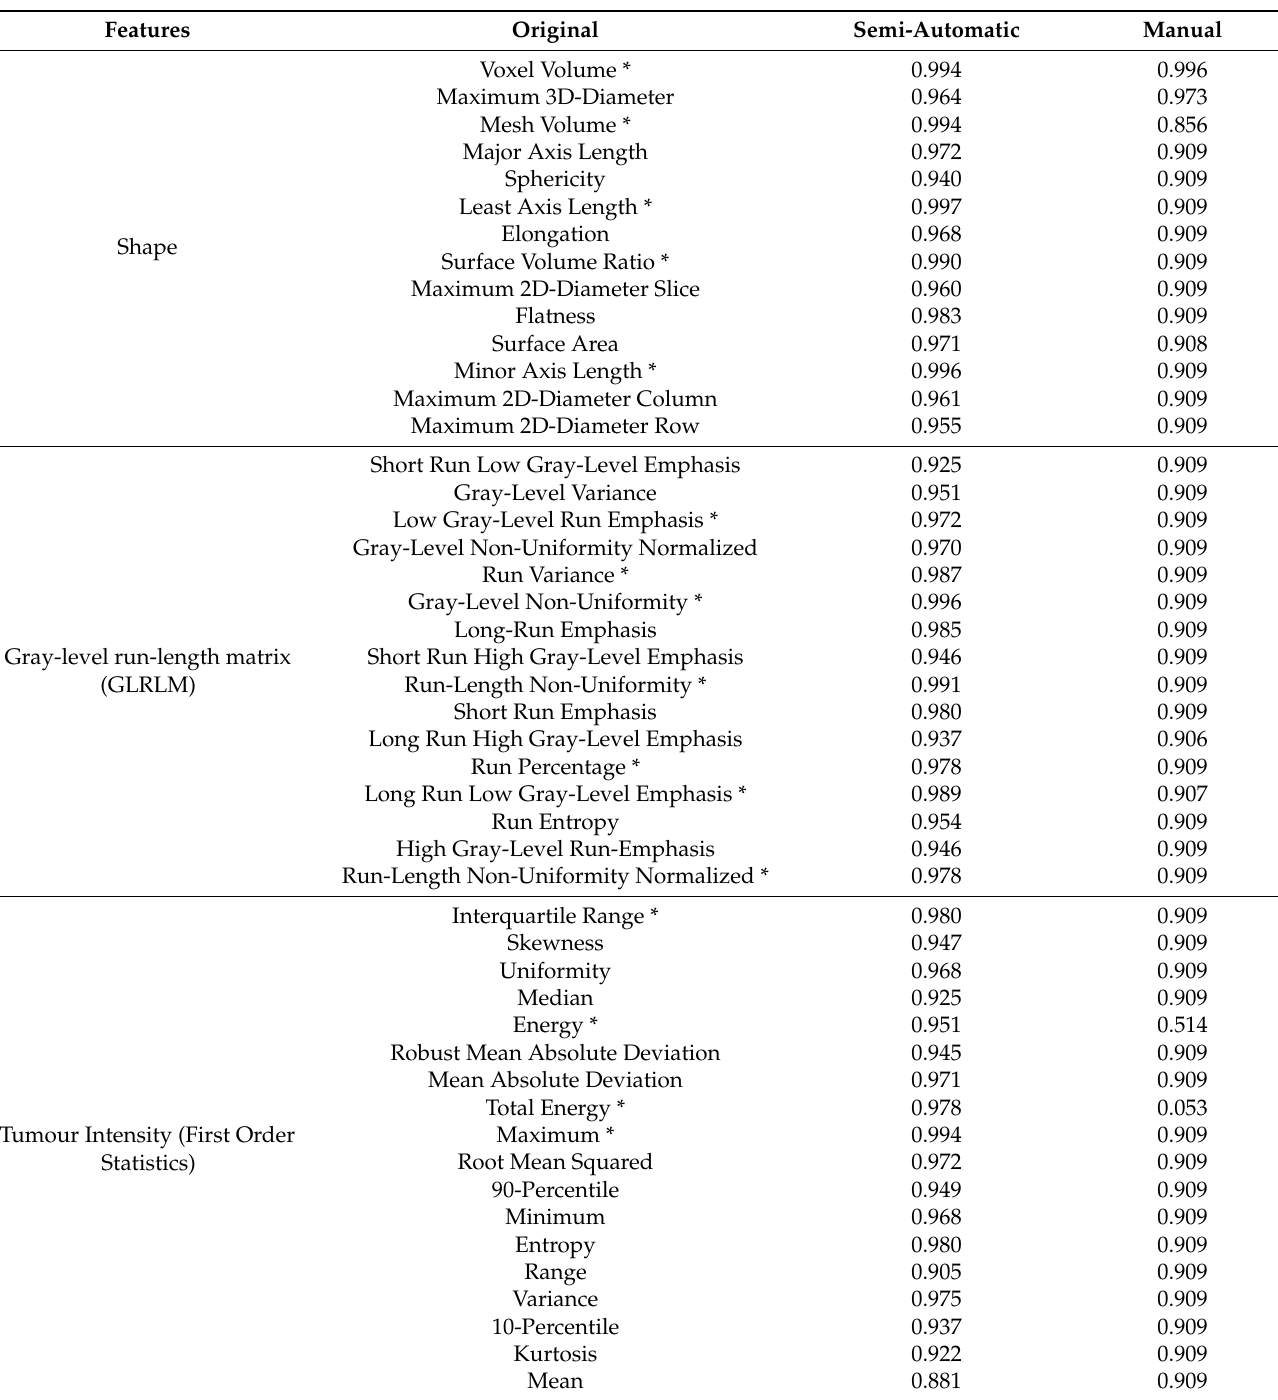
Table 2. Intra-class correlation coefficient (ICC) of semi-automatic and manual segmentation for shape and grey level run length matrix (GLRLM)